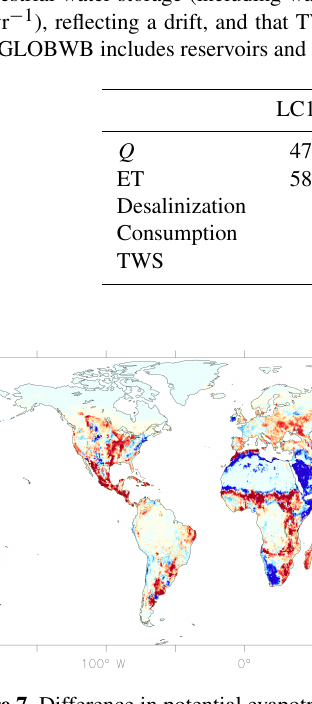
Figure 7. Difference in potential evapotranspiration, averaged over 1979–2010, between LC2000 and LC1850 (in mmyr − 1 ; average of annual totals). Note that there is no difference in potential evapo- transpiration between HUM2000 and